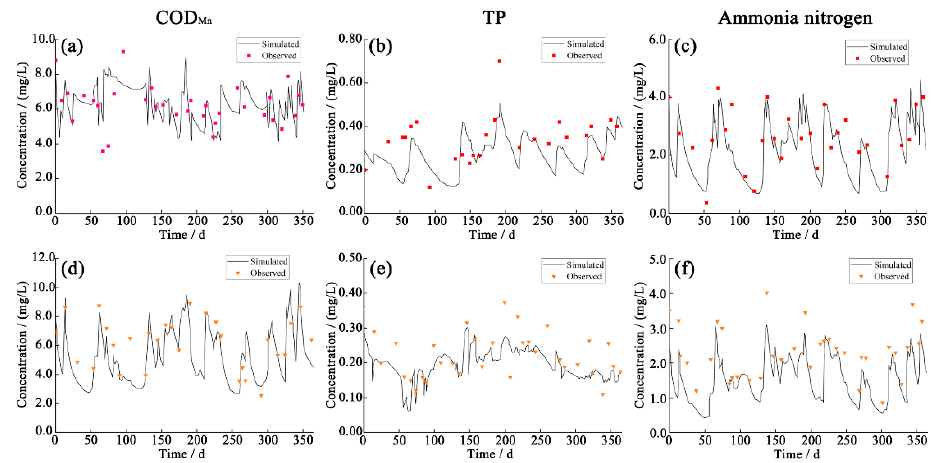
Figure 6. Water quality calibration results at STA1 ( a – c ) and STA2 ( d – f ) of the MIKE11 model.